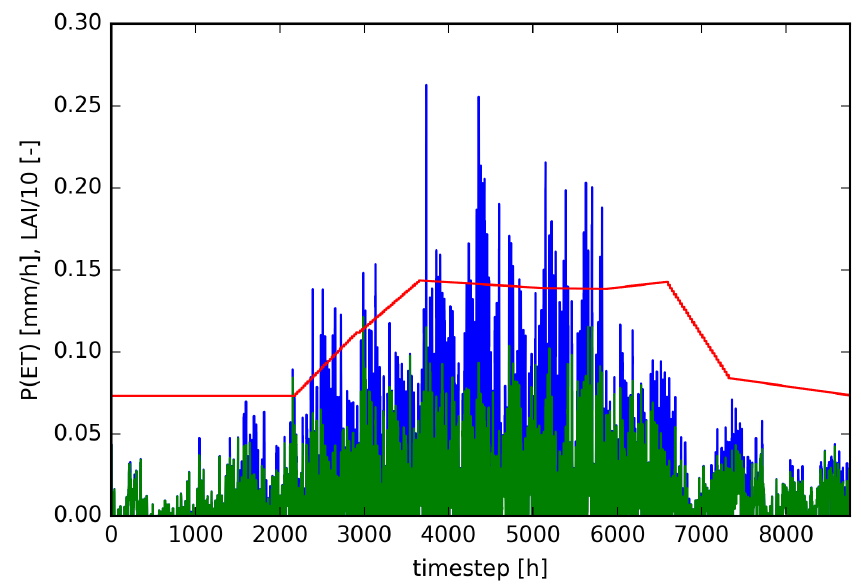
Figure 8. ET (green), PET(blue) and LAI/10 (red) for the Watermaelbeek in 2015 (hourly timestep).